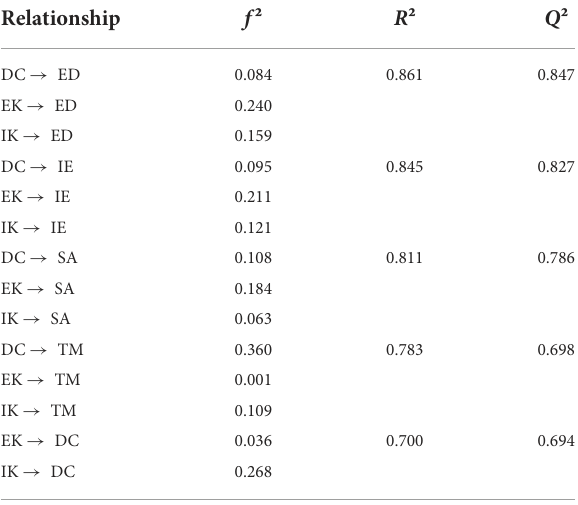
TABLE 10 Verification of the explanatory and predictive abilities of the model.